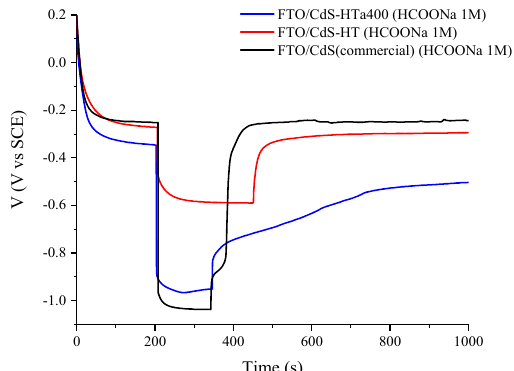
Figure 11. Open circuit potentiometry of FTO/CdS-HTa400 (blue), FTO/CdS-HT (red) and of FTO/CdS (commercial, black) in deaerated aqueous solutions containing HCOONa (1 M).